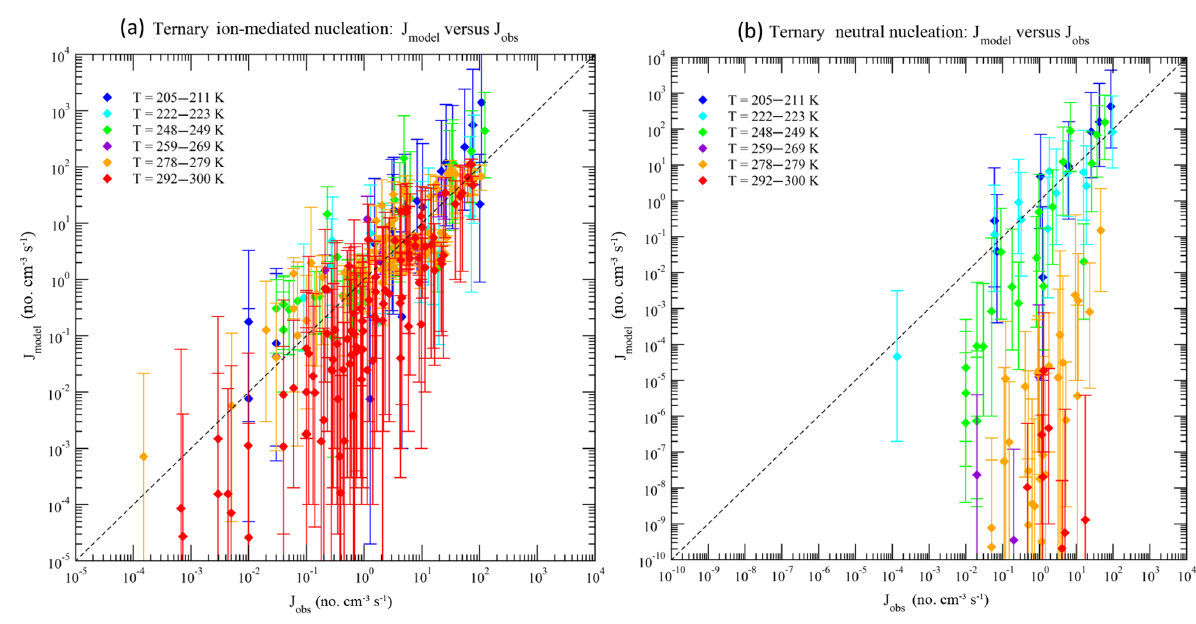
Figure 8. Model predicted ( J model ) versus observed ( J obs ) nucleation rates under various conditions of all 377 data points of CLOUD measurements reported in Table S1 of Dunne et al. (2016), with (a) and without (b) the presence of ionization. The data points are grouped according to temperatures as specified in the legend. Vertical error bars show the range of J model values calculated at 50% and 200% of measured [H 2 SO 4 ], corresponding to the uncertainties in measured [H 2 SO 4 ] ( − 50%, + 100%). Error bars associated with the uncertainties in measured [NH 3 ] ( − 50%, + 100%) and J obs (overall a factor of 2) are not